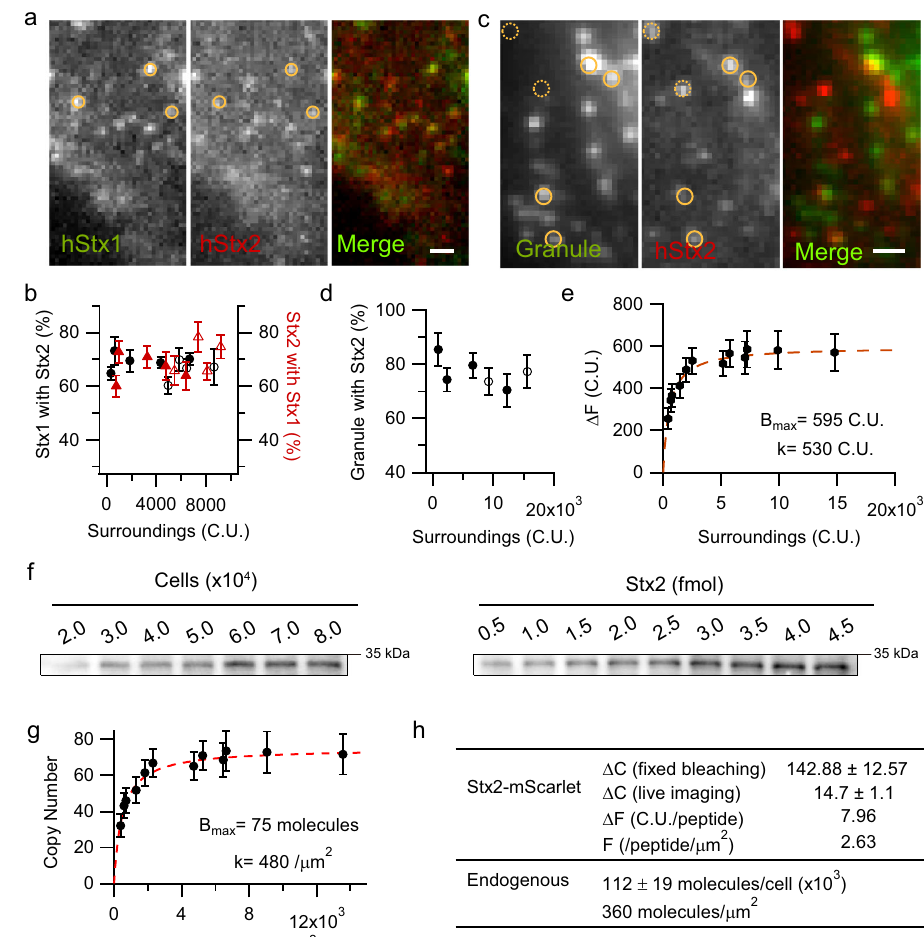
Fig. 2 | Stx2 colocalizes and clusters with Stx1a on secretory granule docking sites. a Representative images of β -cell sparsely coexpressing Stx1a-mNeonGreen and Stx2-mScarlet using the strategy of tandem RT-tags fused constructs. Both imagesaveragedwith3consecutiveframesinamovie,sameregionswereindicated with circles ( n =3 independent experiments). Scale bar, 1 μ m. b Relationships between Stx2 with Stx1a as expression levels are increased. Solid symbols indicate measurement with RTs strategy, empty symbolsby CMV promoter. c Stx2 clusters beneath the secretory granules. Human β -cell coexpressing NPY-EGFP and RTs- Stx2-mScarlet. The circle indicates granule-associated Stx2 cluster and dashed circle indicates granule-unrelated to Stx2. Images showed an average of every 100th frame in a movie, 5 frames in total. Scale bar, 1 μ m. d The percentage of dockedgranules withStx2 cluster remain constant regardless of expression levels. e The fl uorescent intensity of Stx2 clusters correlates with the overall expression level. The fl uorescent intensity of granule-associated Stx2, Δ F, varied with that of granule-unrelated Stx2, surrounding annulus, S. The curve is fi tted by a reversible protein-binding to fi xed target sites model, Δ F = B max × S /(k+S), as the dashed red lineindicated, B max =595C.U.anddissociationconstant, k =530C.U. f Quantitative